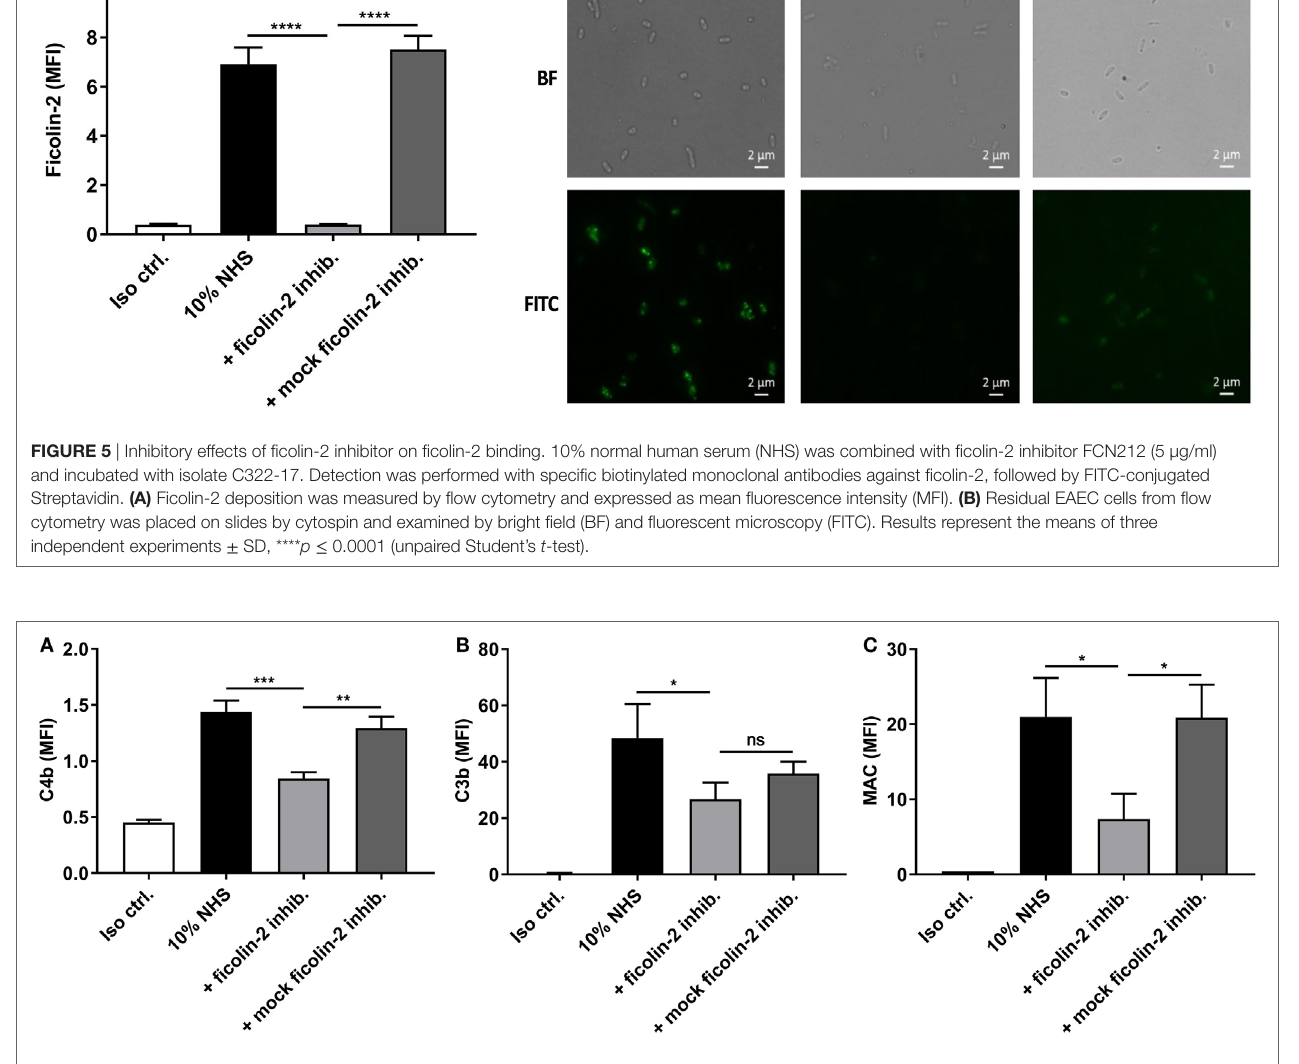
FigUre 6 | Inhibitory effects of a ficolin-2 inhibitor on C4b, C3b, and membrane attack complex (MAC) deposition. 10% normal human serum (NHS) was combined with ficolin-2 inhibitor FCN212 (5 µg/ml) and incubated with isolate C322-17. Detection was performed with specific biotinylated monoclonal antibodies against (a) C4b, (B) C3b, and (c) MAC, followed by FITC-conjugated Streptavidin. Complement deposition was measured by flow cytometry and expressed as mean fluorescence intensity (MFI). Results represent the means of three independent experiments ± SD, ns p > 0.05, * p ≤ 0.05, ** p ≤ 0.01, *** p ≤ 0.001 (unpaired Student’s t -test).